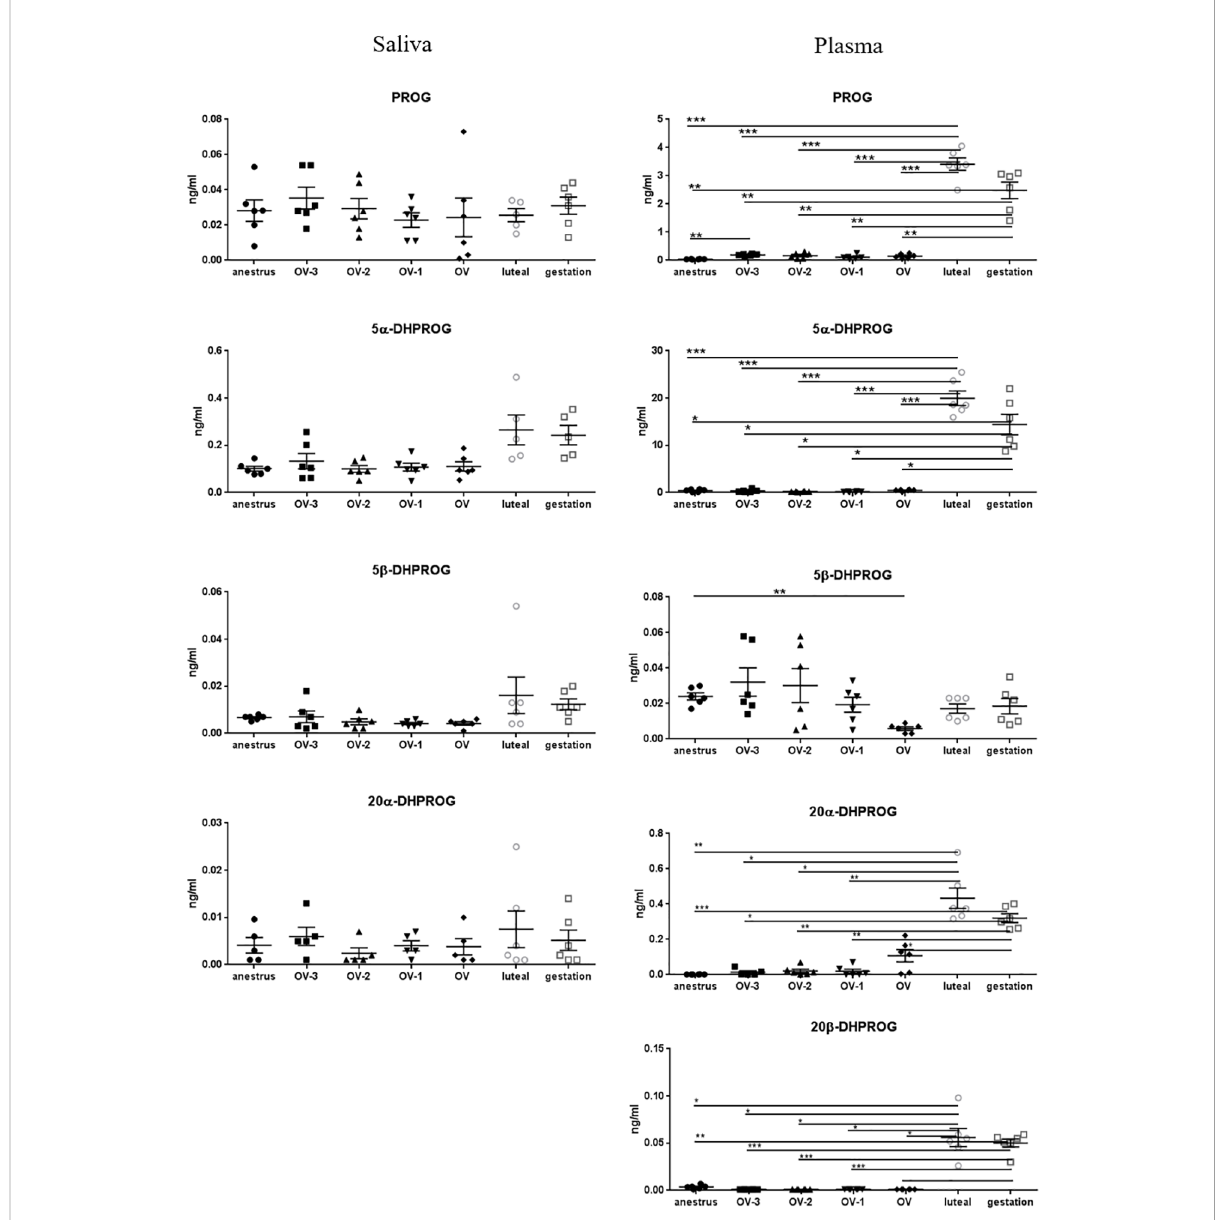
FIGURE 2 Gas chromatography coupled to tandem mass spectrometry (GC-MS/MS) measurements of the concentrations of progesterone (PROG), 5 a - dihydroprogesterone (5 a -DHPROG), 5 b -DHPROG, 20 a -DHPROG and 20 b -DHPROG (ng/mL ± SEM) in mare saliva and plasma collected during anestrus, during follicular phase 3 days (OV-3), 2 days (OV-2) and 1 day (OV-1) before ovulation, the day when ovulation was detected (OV), during luteal phase 6 days post-ovulation (luteal), during gestation 18 days post-ovulation (gestation). For each steroid, the y-axis was standardized to the maximal concentration, so that the variations are easy-to-read. Statistical differences between physiological stages: * P < 0.05, ** P < 0.01, *** P <